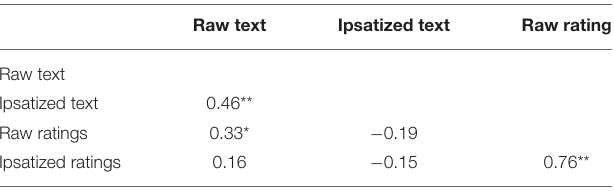
TABLE 4 | Overall similarity of the correlation matrices (using Mantel test) in Study